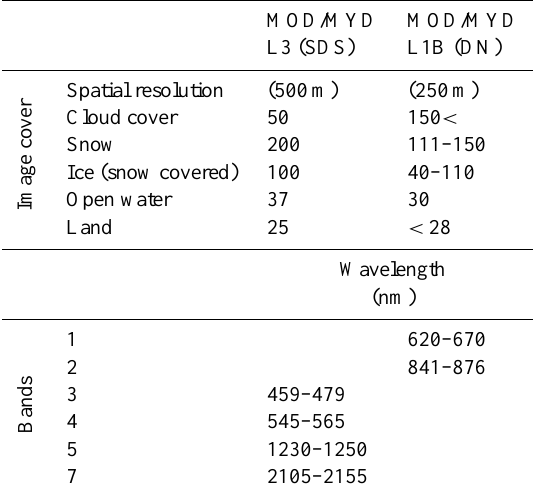
Table 2. Scientific data set (SDS) and digital number (DN) values from MODIS L1B and L3 products used for the Mackenzie River.